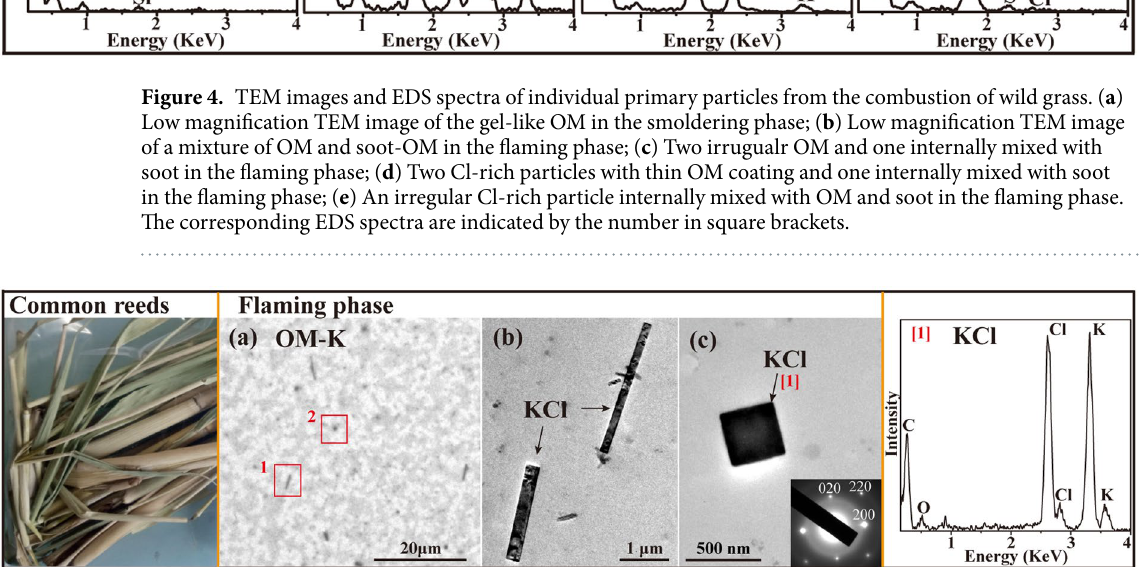
Figure 5. TEM images and EDS spectra of individual primary particles from the combustion of common reeds. ( a ) Low magnification TEM image of gel-like OM particles internally mixed with KCl in the flaming phase; ( b and c ) Two rectangle and one square KCl particles corresponding to red square 1 and 2 in ( a ), respectively. The inset shows the electron diffraction patterns of KCl. The corresponding EDS spectra are indicated by the number in square